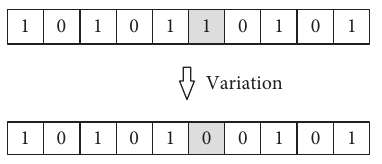
Figure 3: The basic principle of bit variation. Table 1: Simulation experiment parameters.